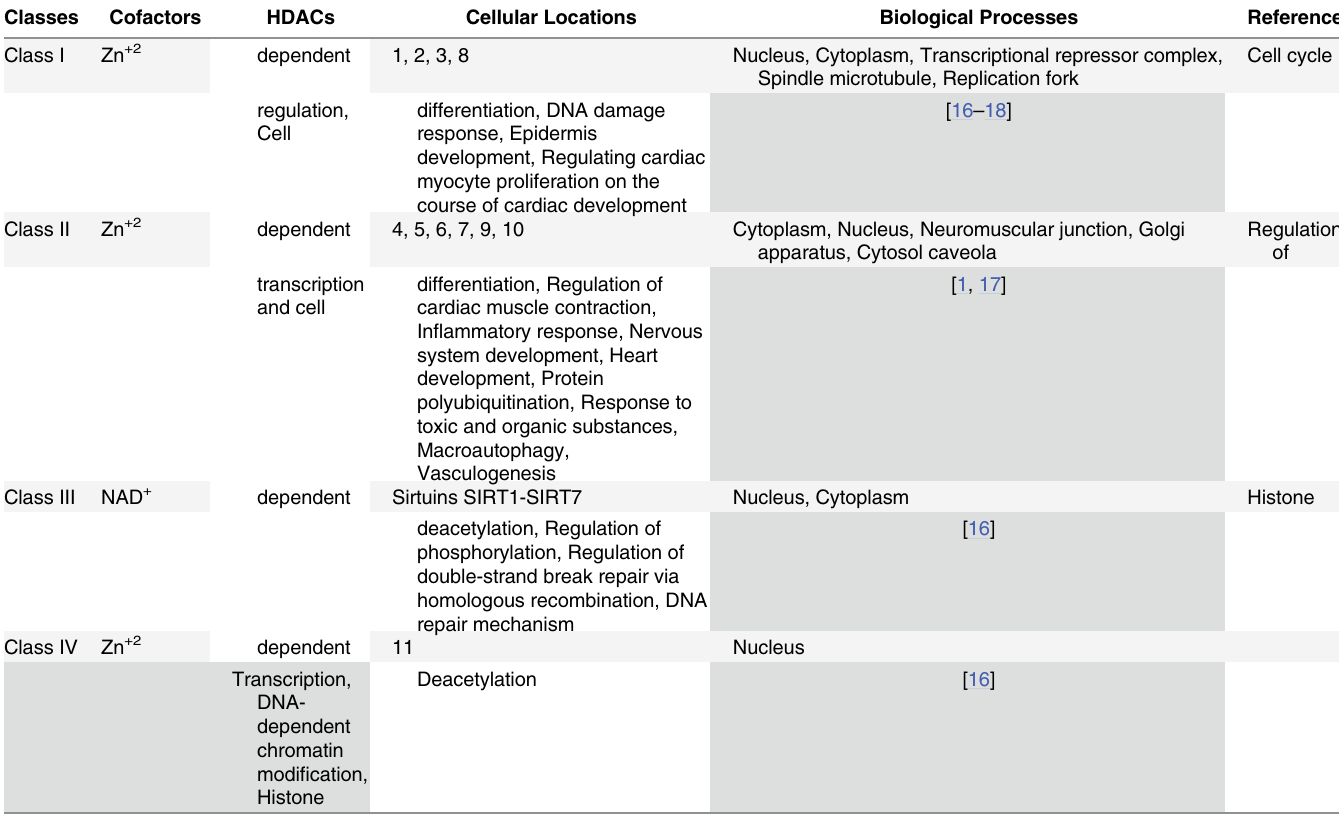
Table 1. Classification and biological roles of